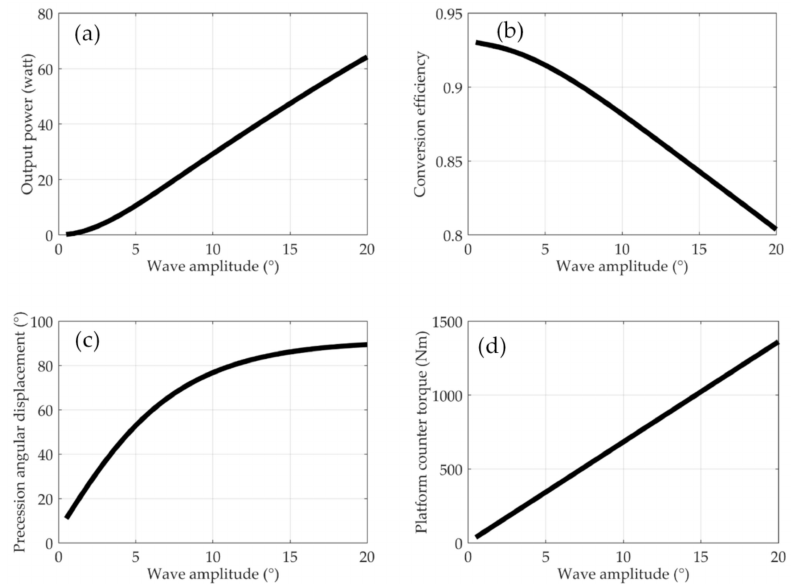
Figure 10. Effect of pitch amplitude: ( a ) output power; ( b ) conversion efficiency; ( c ) flywheel precession angular displacement; ( d ) platform counter torque.